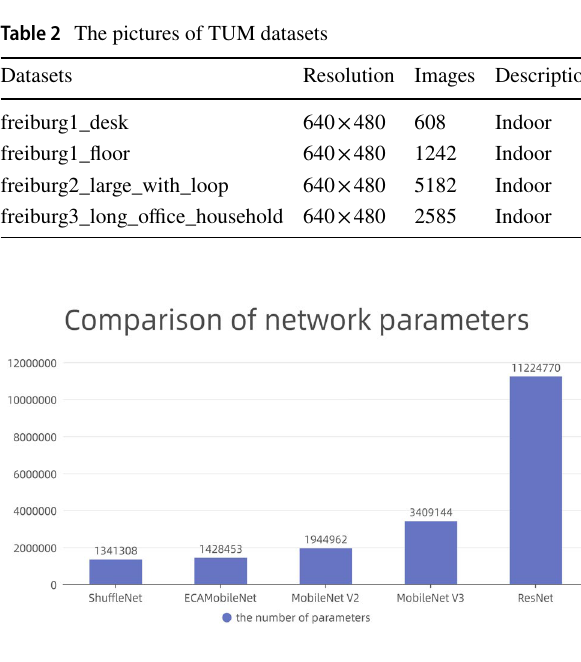
Fig. 9 This figure express the parameters of neural networks, and the parameters of ECMobileNet are very